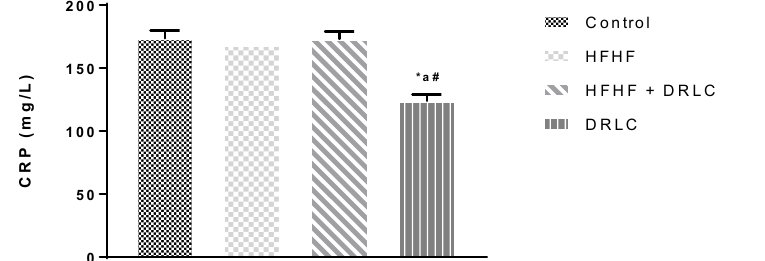
Figure 3. Serum CRP (C-reactive protein). n = 5. Values were expressed as Mean ± SEM, * significantly different from control ( p < 0.05); # significantly different from HFHF ( p < 0.05); a significantly different from HFHF + DRLC ( p < 0.05). NB: Control, HFHF (high fructose high fat), HFHF + DRLC (D-ribose-L-cysteine) and DRLC in Wistar rats after 8 weeks of DRLC treatment.